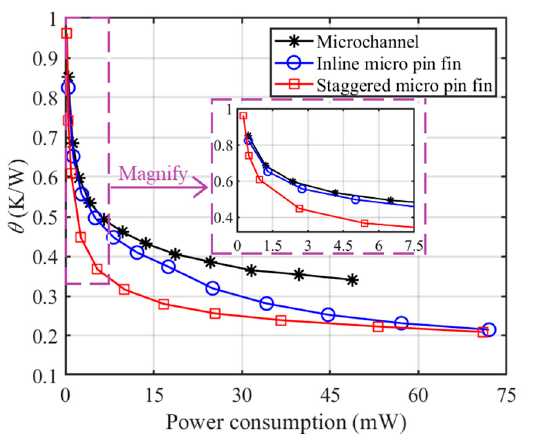
Figure 10. Variations of the average thermal resistance with power consumption.